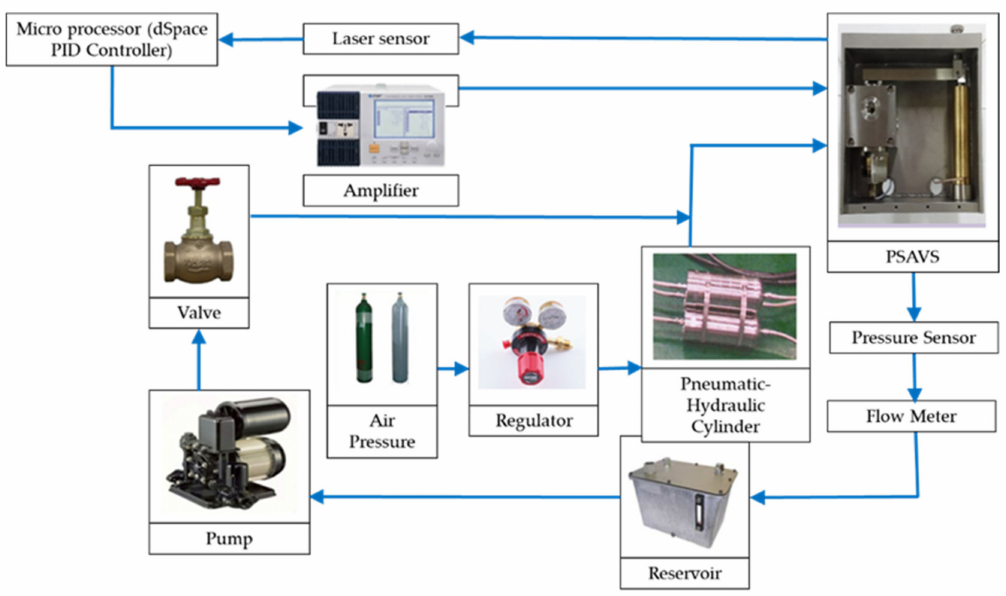
Figure 8. An experimental block-diagram for spool displacement control.